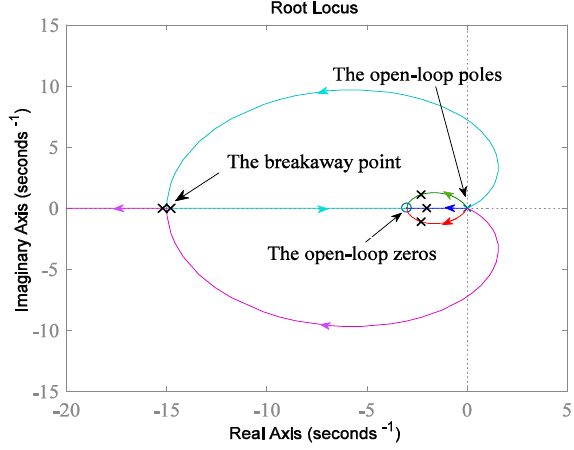
Figure 4. Root loci of the fifth-order HOD ( 3 a = ).